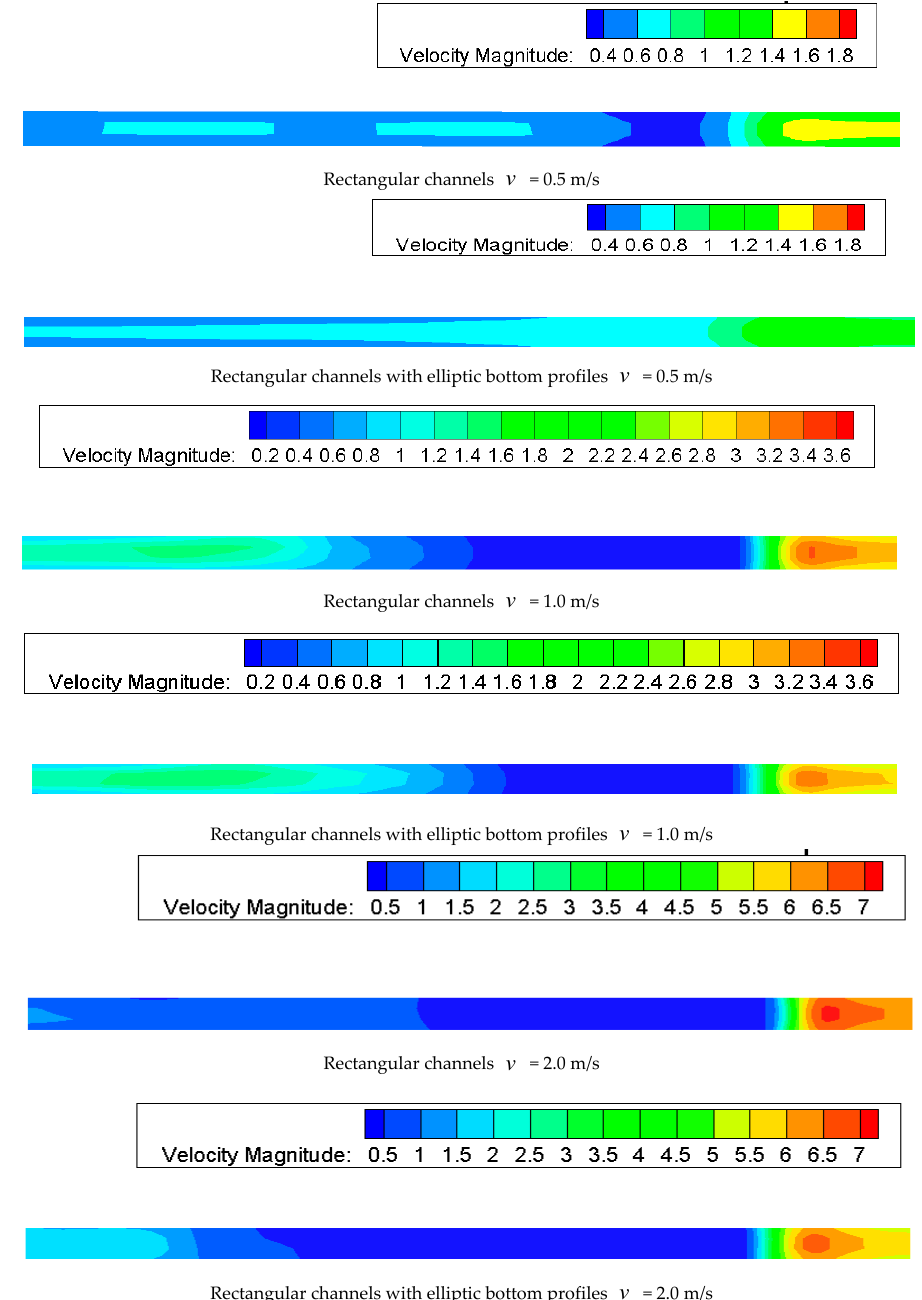
Figure 13. Comparisons of the velocity distributions at the plane of half fin height Z = 13.25 mm for the plate fin heat sinks #1 and #5.